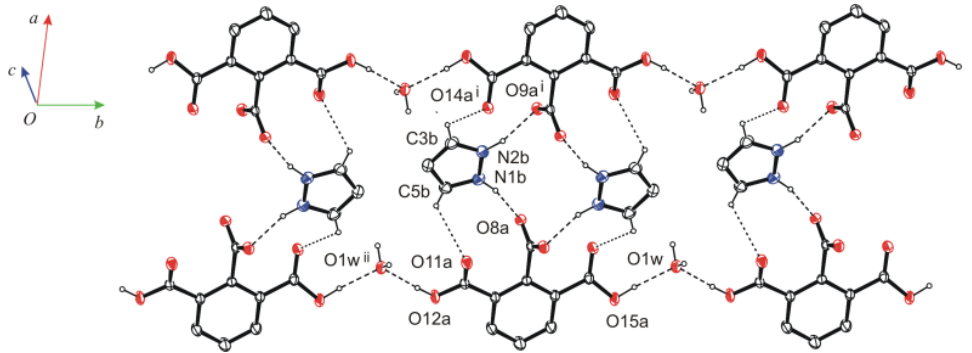
Figure 2. Hydrogen bonds linking molecules into tapes growing along the b -axis.